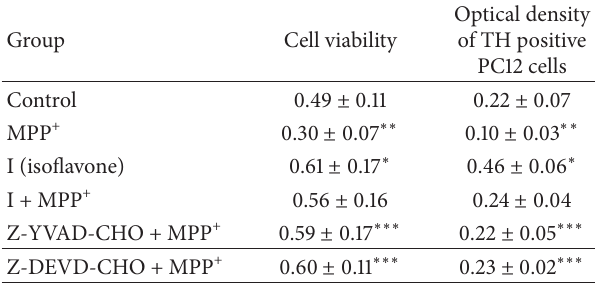
Table 1: MTT assay of cell viability and optical density of TH positive PC12